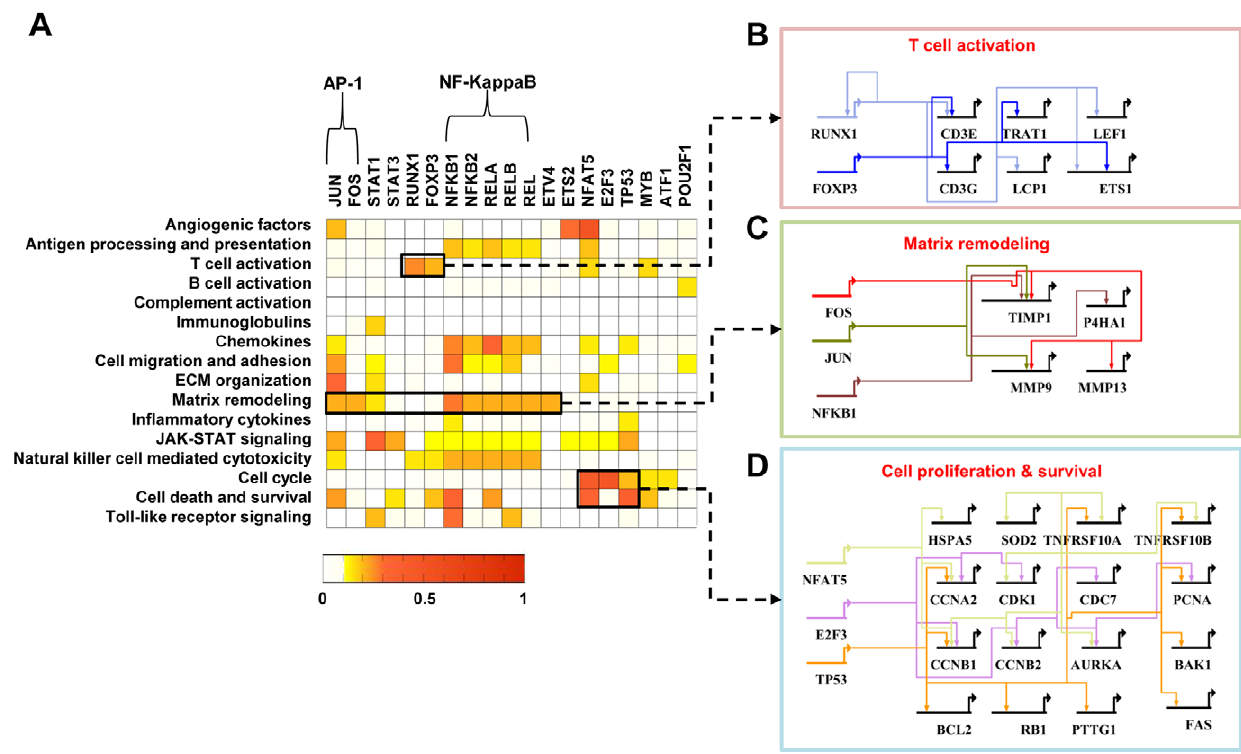
Figure 4. Gene regulatory networks activated in RA. A) Target enrichment scores representing the significances of overlaps between the targets of each TF and the RAGs belonging to the network modules. B–D) Gene regulatory networks describing the TF-target relationships for the three processes: T-cell activation including RUNX1 and FOXP3 (B), Matrix remodeling including AP-1 (JUN and FOS) and NFKB1 (C), and Cell proliferation and survival including NFAT5, E2F3, and TP53 (D).